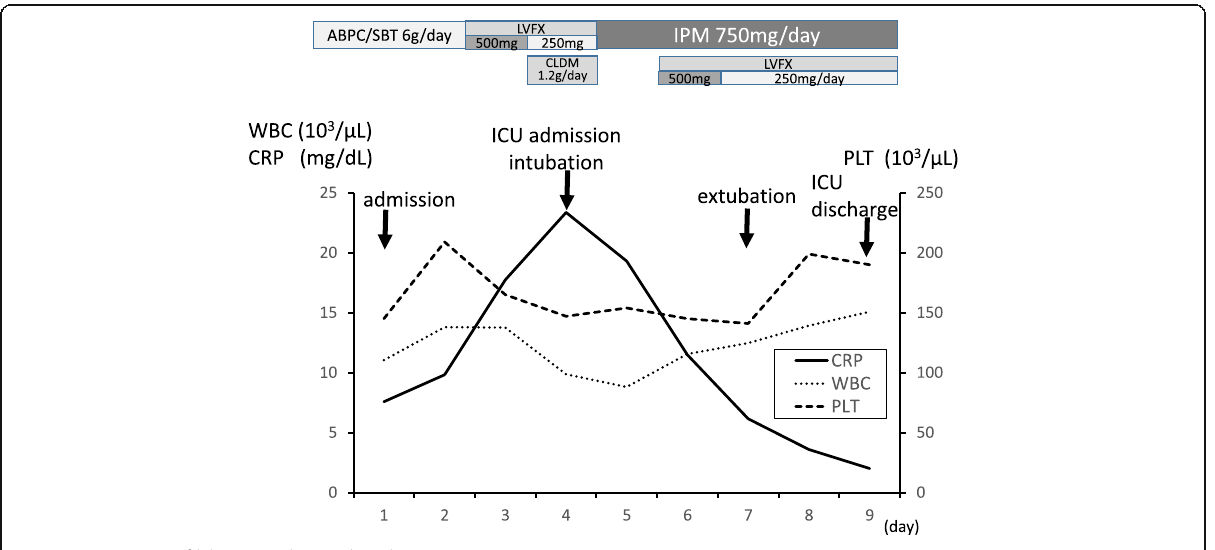
Fig. 2 Time course of laboratory data and antibiotic treatment